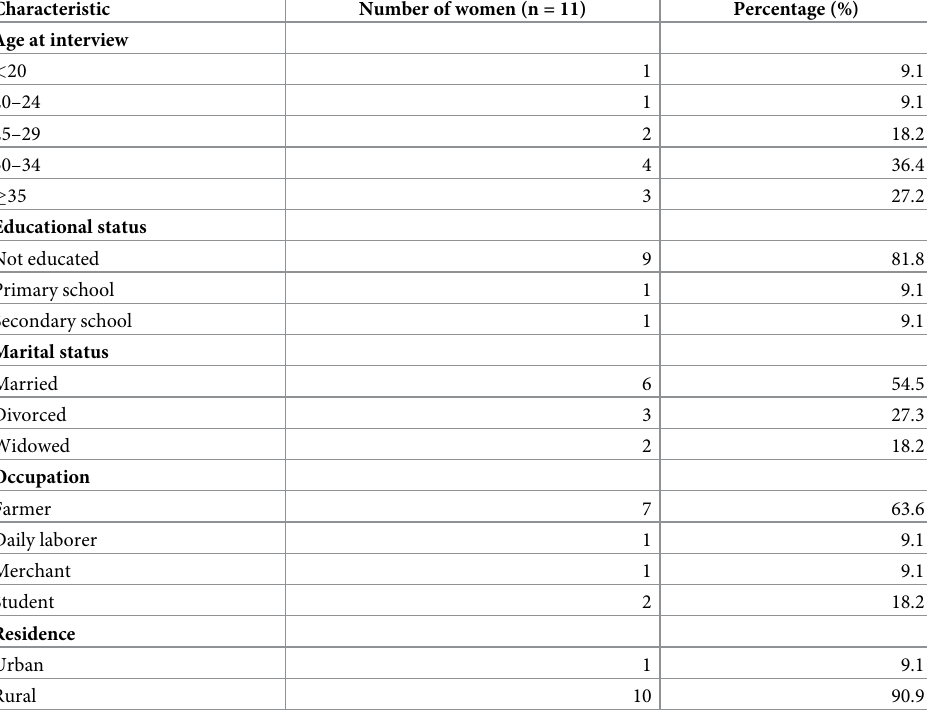
Table 1. Socio-demographic characteristics of women with obstetric fistula participated in an in-depth interview at Addis Ababa and Oromia Fistula centers, April to August 2019 (n = 11).